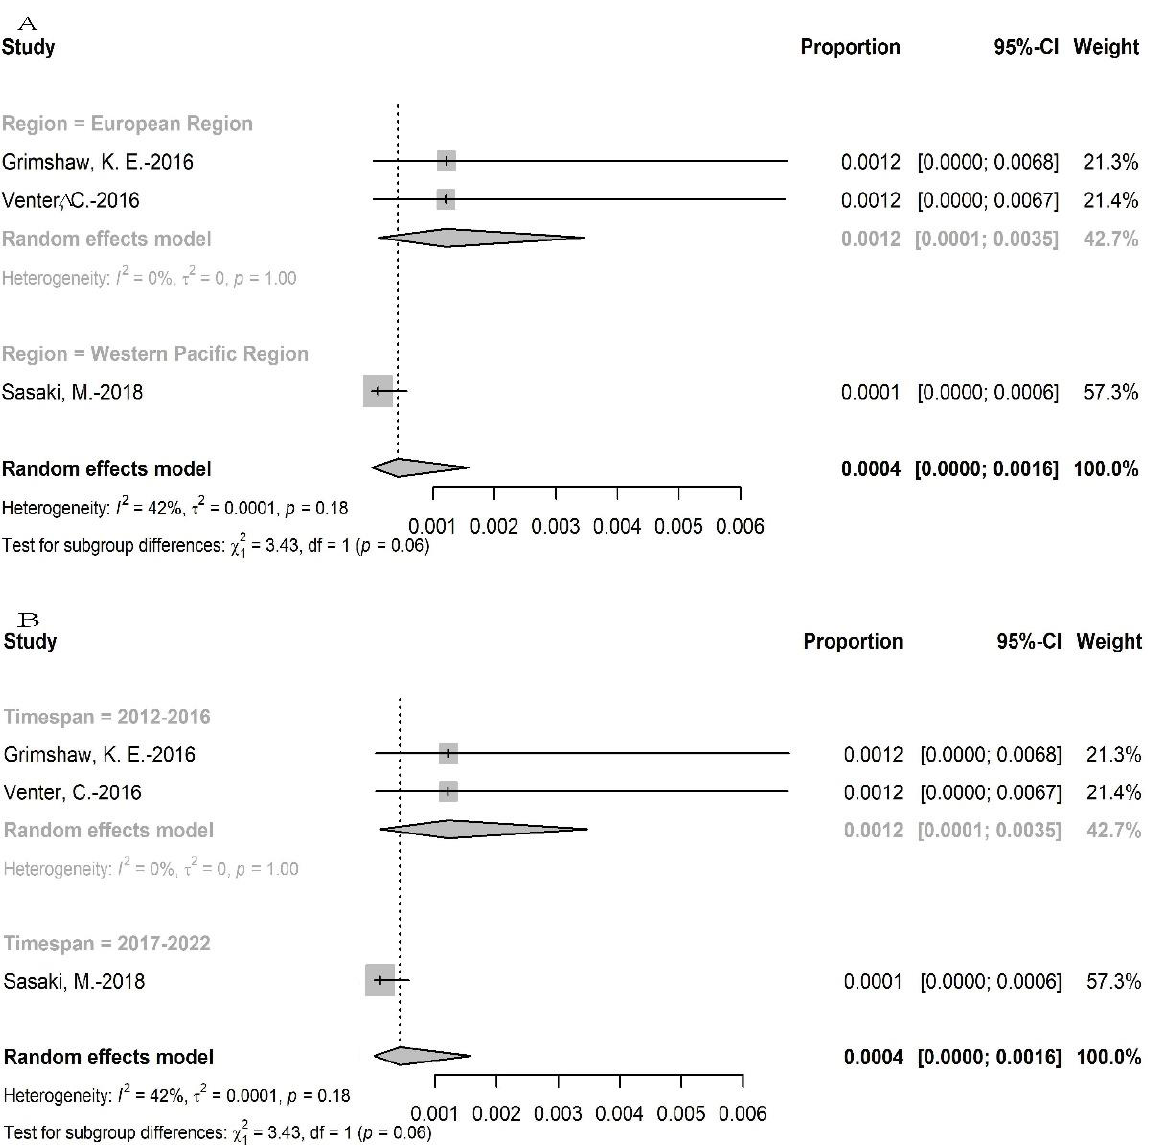
Figure 6. The prevalence of wheat allergy confirmed by food challenge ( A ): the subgroup analysis for region, ( B ): the subgroup analysis for timespan [29,52,60].